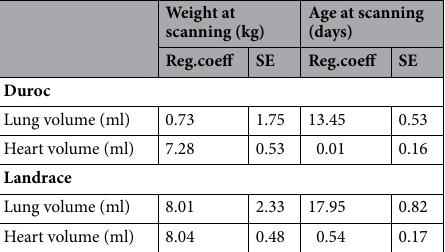
Weight at scanning (kg)